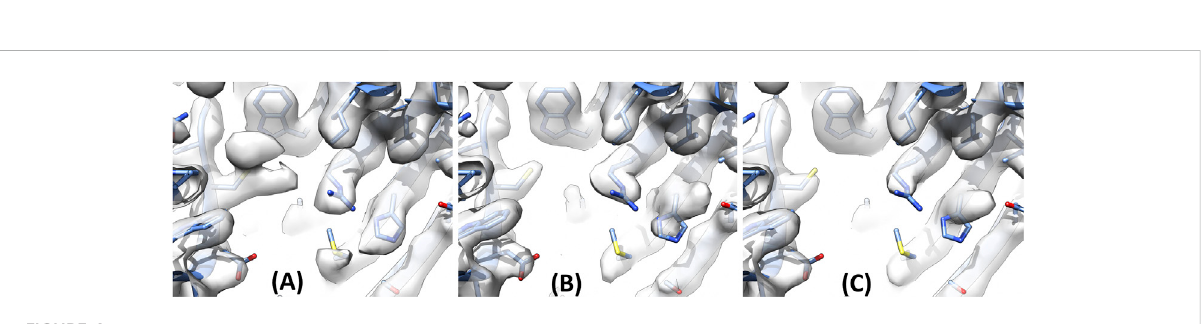
FIGURE 4 B-gal Cysteine 914 and Histidine 653 under different grid preparation conditions. (A) “ Blotted ” β -gal shows additional density for Cys914. (B) “ Fast ” β -gal and (C) “ 1 mM DTT ” β -gal show no additional density for Cys914. His653 adopts a different rotamer in “ blotted ” β -gal (A) where a modi fi cation is seen on Cys914, compared to (B) , (C)